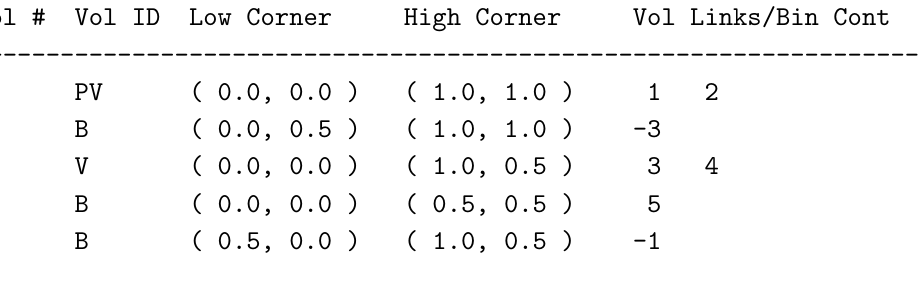
Figure 15 . Representation of the hyper-binning in (cid:12)gure 14 using the same format as hypbinningwlinks.txt